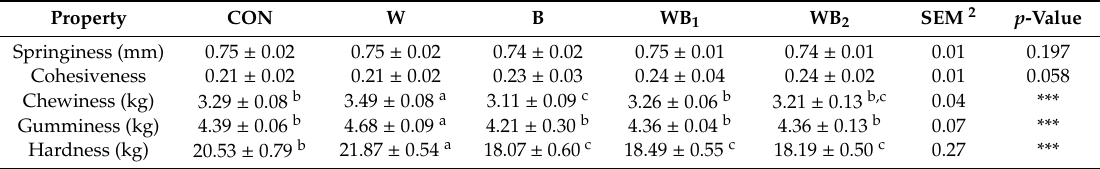
Table 4. Texture profile analysis of pork patties formulated with Boswellia serrata and whey powders 1.